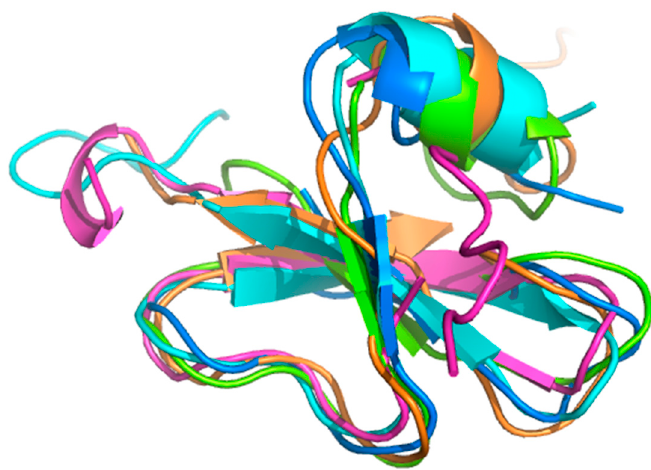
Figure 1. Superposition of reported structures for five human β -defensins (HBDs). Represented are HBD1 (protein data bank 1KJ5, blue), HBD2 (1FQQ, green), HBD3 (1KJ5, orange), HBD4 (5KI9, pink),